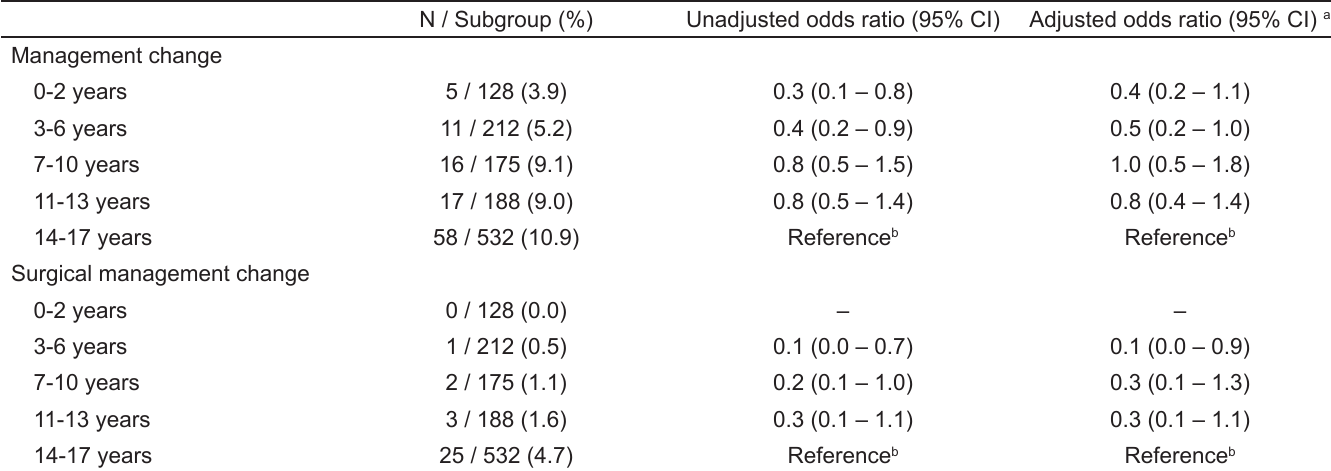
Table 3a. Associations between age and changes in clinical and surgical management.